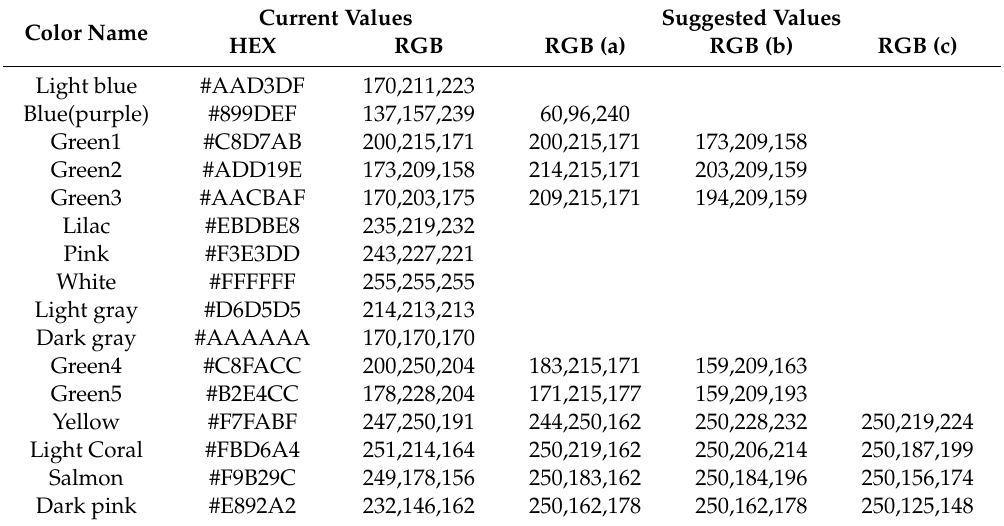
Table A2. The OpenStreetMap color coordinates.